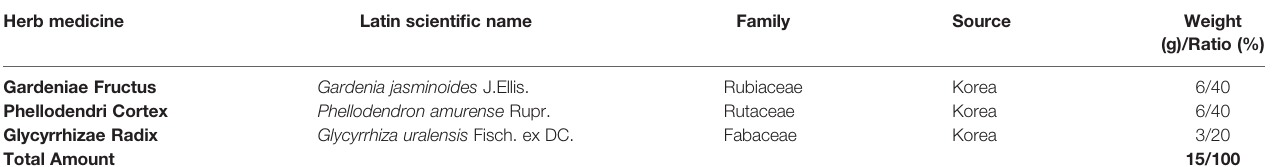
TABLE 1 | The composition of Chijabyukpi-tang